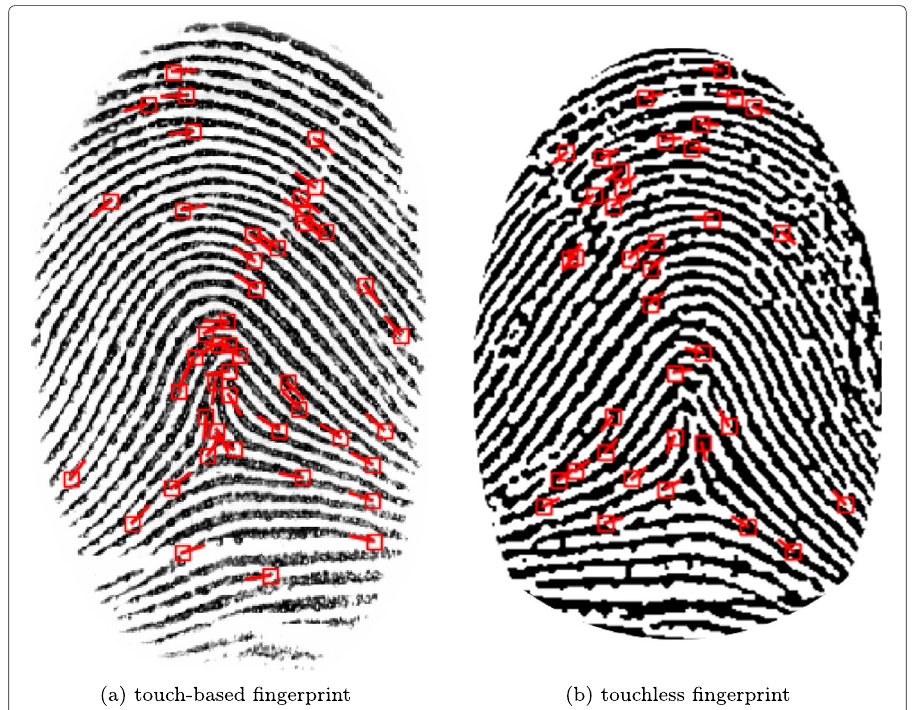
Fig. 6 Feature extraction. Minutiae points extracted from the touch-based fingerprint ( a ) and a touchless fingerprint ( b ). The feature extraction was performed with FingerNet [72]. Please note that due to the different capturing process, the touchless fingerprint image is